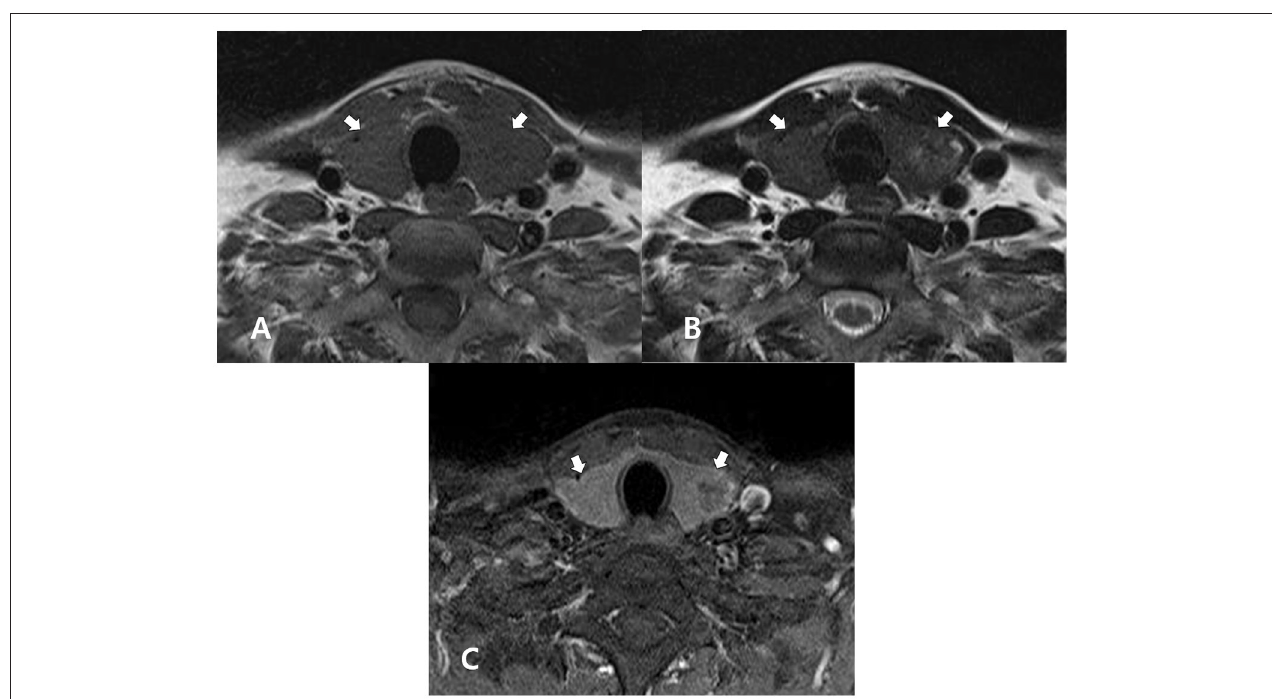
FIGURE 1 | A 51-year-old man with normal thyroid parenchyma confirmed by histopathology after thyroid surgery for the treatment of papillary thyroid carcinoma. In the non-enhanced axial T1- (A) and T2- (B) weighted images, the thyroid gland (arrows) exhibits homogeneous, iso-, and slightly high signal intensities, respectively, when compared with adjacent muscle. In both images, the thyroid gland (arrows) exhibits a normal size and smooth margin. In the enhanced axial, fat-suppression T1-weighted image (C) , the thyroid gland (arrows) exhibits homogeneously increased enhancement, when compared with adjacent muscle.